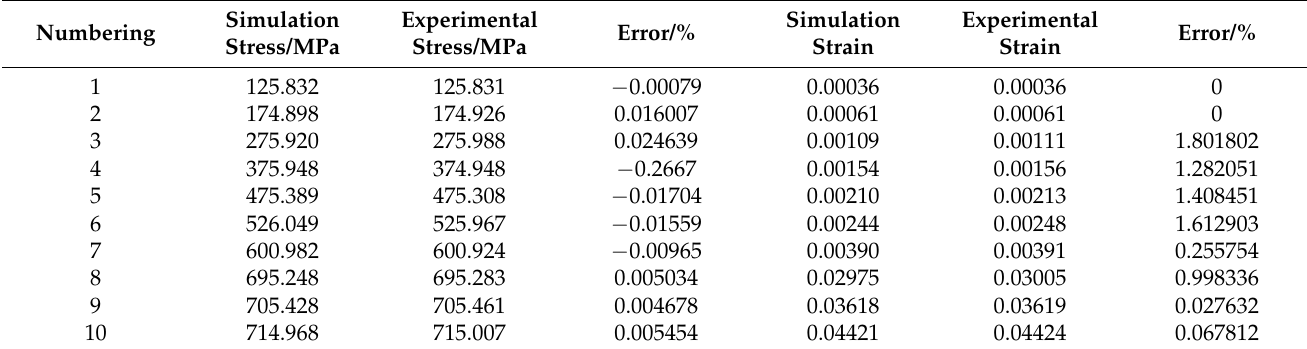
Table 2. Errors between simulation results and experimental